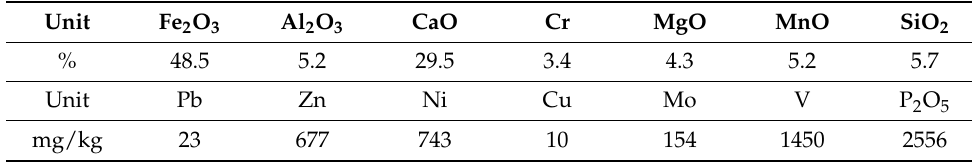
Table 1. Chemical composition of EAF slag, obtained by inductively coupled plasma atomic emission spectroscopy